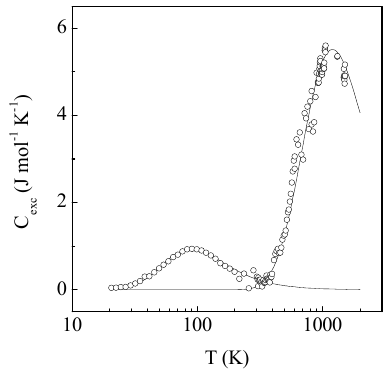
Figure 1. Temperature dependence of the excess electronic heat capacity of the Al 63 Cu 25 Fe 12 quasicrystalline alloy with respect to the Sommerfeld metallic contribution. Solid lines show the approximation of the curve by two Schottky contributions with excitation energies of 0.02 and 0.25 eV.